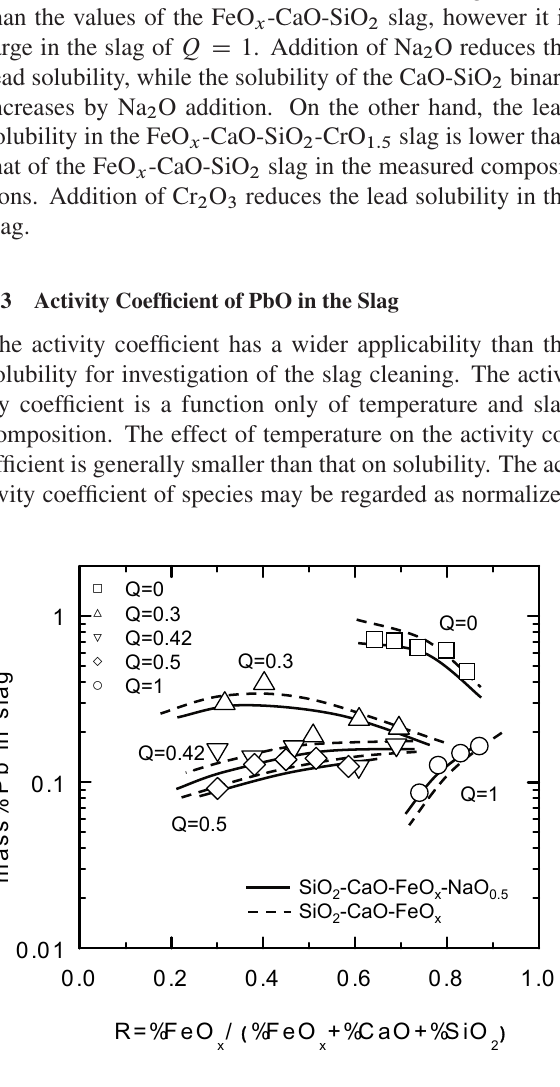
Figure 3. Lead solubility in the FeO x -CaO-SiO 2 -NaO 0:5 slag with iron saturation at 1573 K.